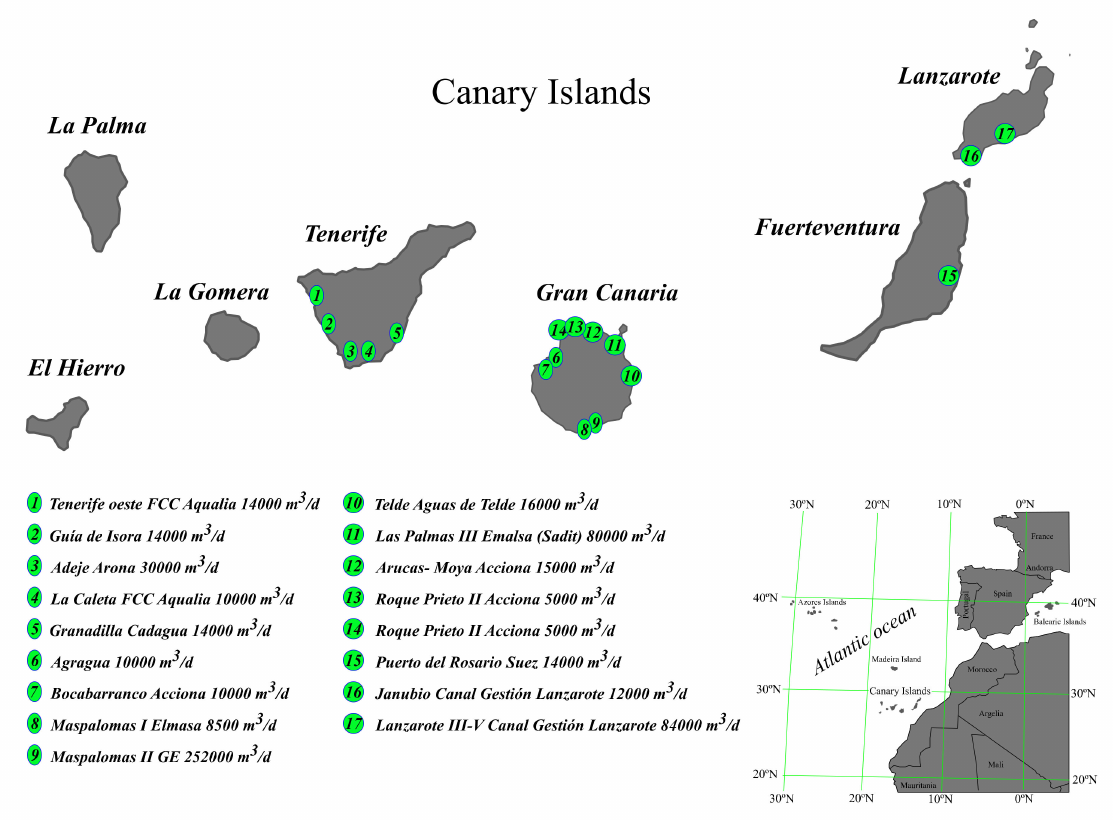
Figure 2. Most significant seawater desalination plants (2019).